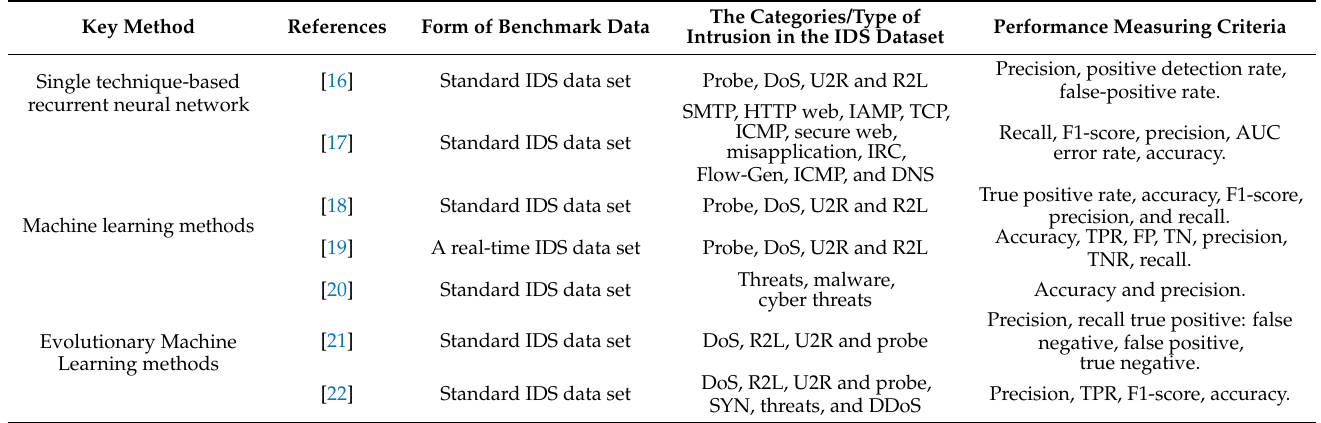
Table 2. The present state of the art in the field of intrusion detection research.